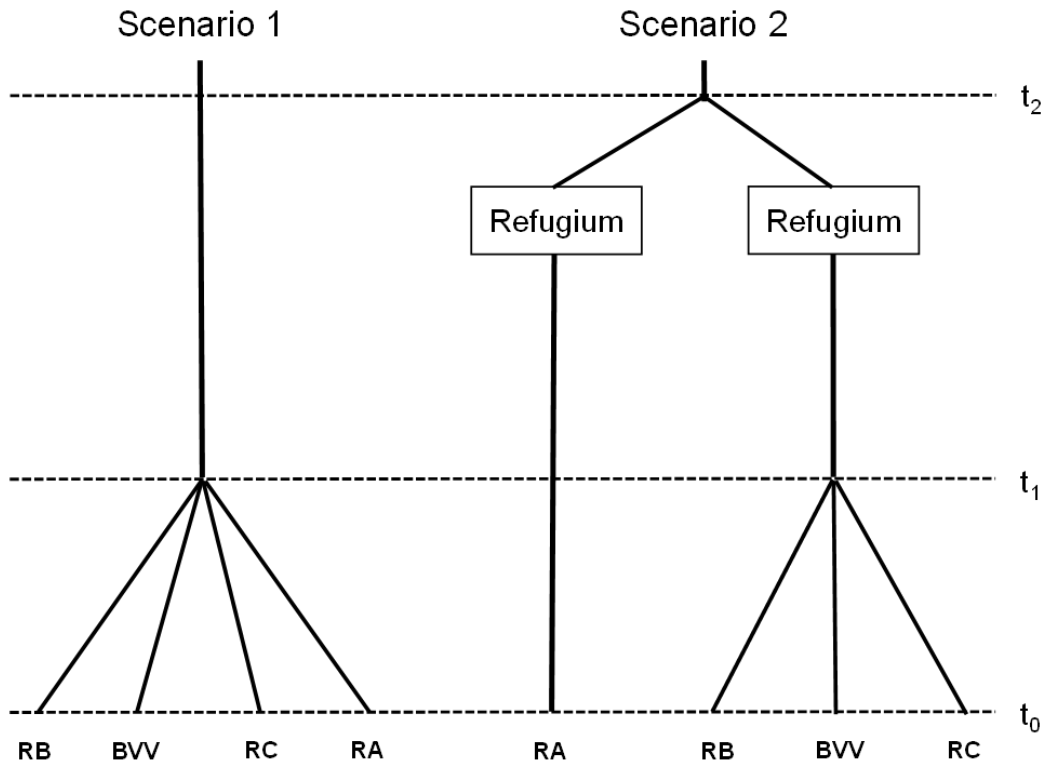
Figure 2. The two demographic scenarios tested for populations of C. ambigua in the Amazon River and Paraguay River basins of Brazil using DIYABC [59,60]. Each scenario assumes four extant populations at t 0 , where RB = Baixo Stream, BVV = Valo Verde Lake, RC = Claro Stream, and RA = Amazon River, populations, respectively, and that they diverged from each other at some point in the past. Divergence time-points t 1 and t 2 are displayed on right.